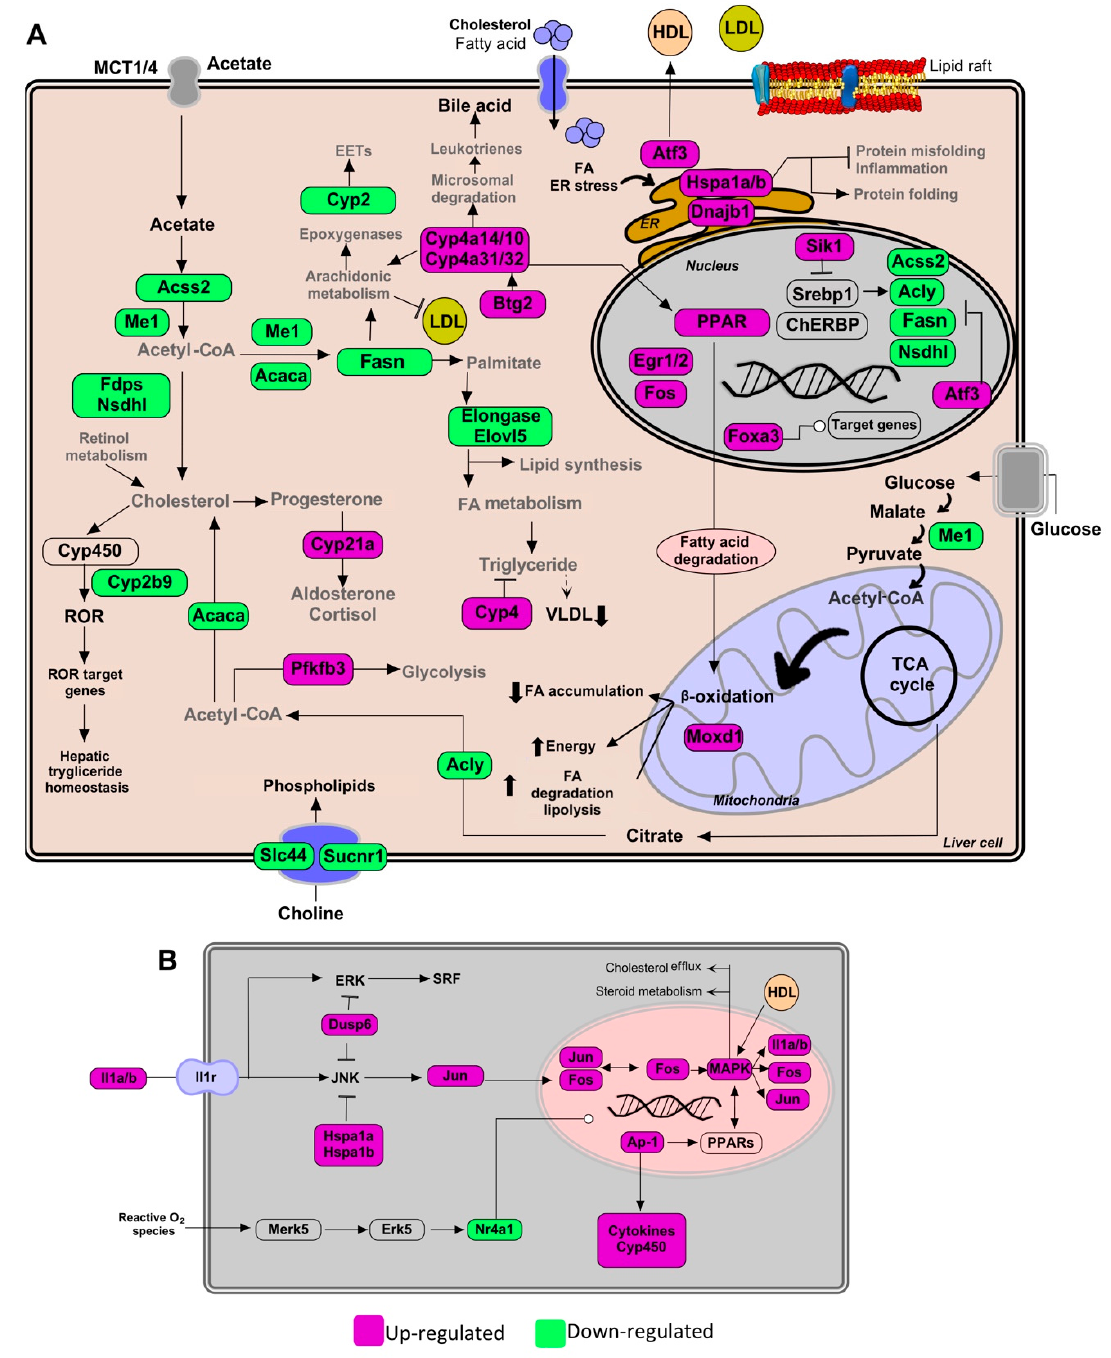
Figure 3. Pathways of lipid metabolism modulation in hepatic tissue by the Gl -2 extract of a Mexican strain of Ganoderma lucidum , under a high-cholesterol diet (HCD) given to C57BL/6 mice. ( A ) Lipid metabolic network and genes modulated by Gl -2 extract consumption. ( B ) Schematic outline of PPAR activation pathway up-modulated by higher expression levels of MAPK family genes and AP-1. Green shaded boxes indicate significant down-modulation, while magenta shaded boxes indicate significant up-modulation of a gene in mice fed with a HCD and treated with Gl -2 extract versus mice fed with a HCD only. EETs: epoxyeicosatrienoic acids. ER: endoplasmic reticulum.